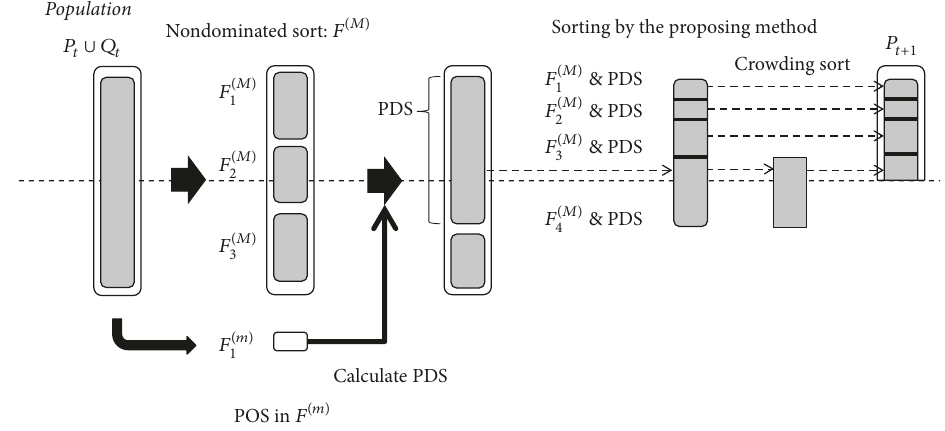
Figure 3: Single population